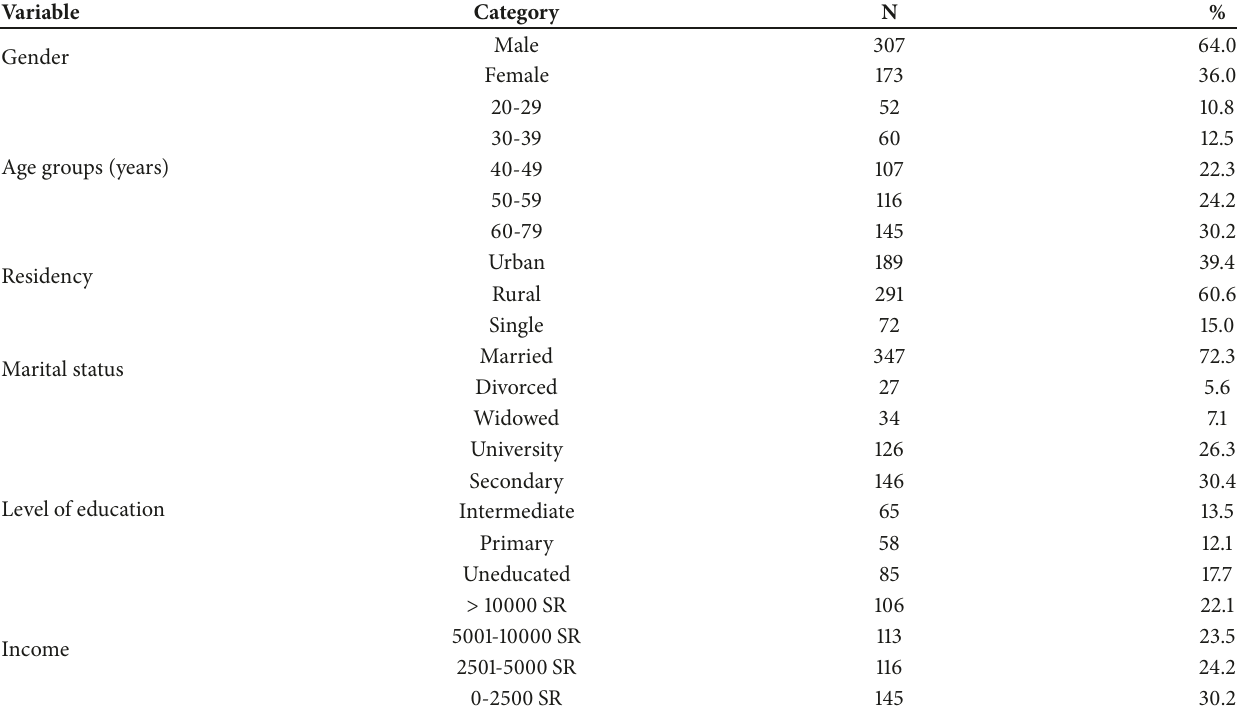
Table 1: Sociodemographic characteristics of diabetic patients, Jazan, May 2017 (N = 480).